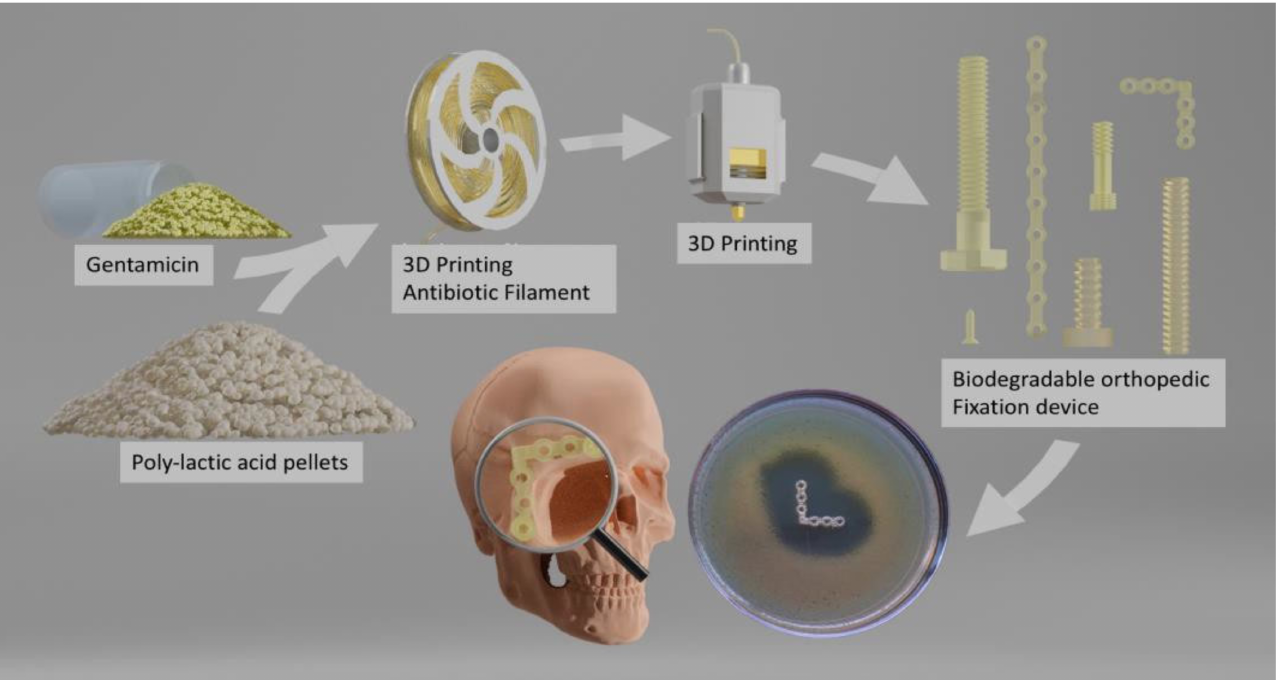
Figure 6. Examples of 3D printed devices fabricated from an antimicrobial filament